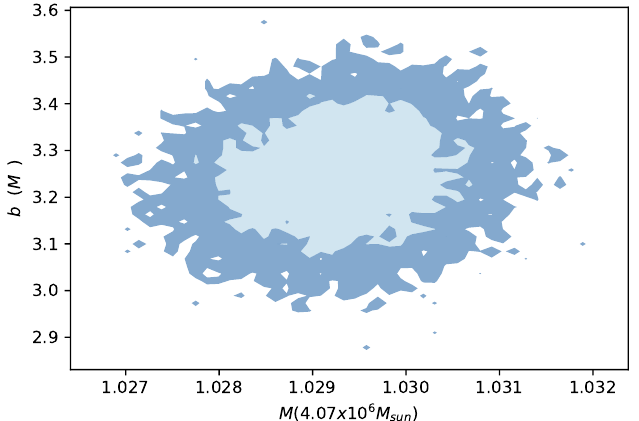
Figure 8. The plot shows the orbit of S2 star around the Sgr A (cid:63) BH as a model fitting using the quantum deformed BH. We used the observational data from [36] and the best fit values obtained for deformed parameter b and the black hole mass M .